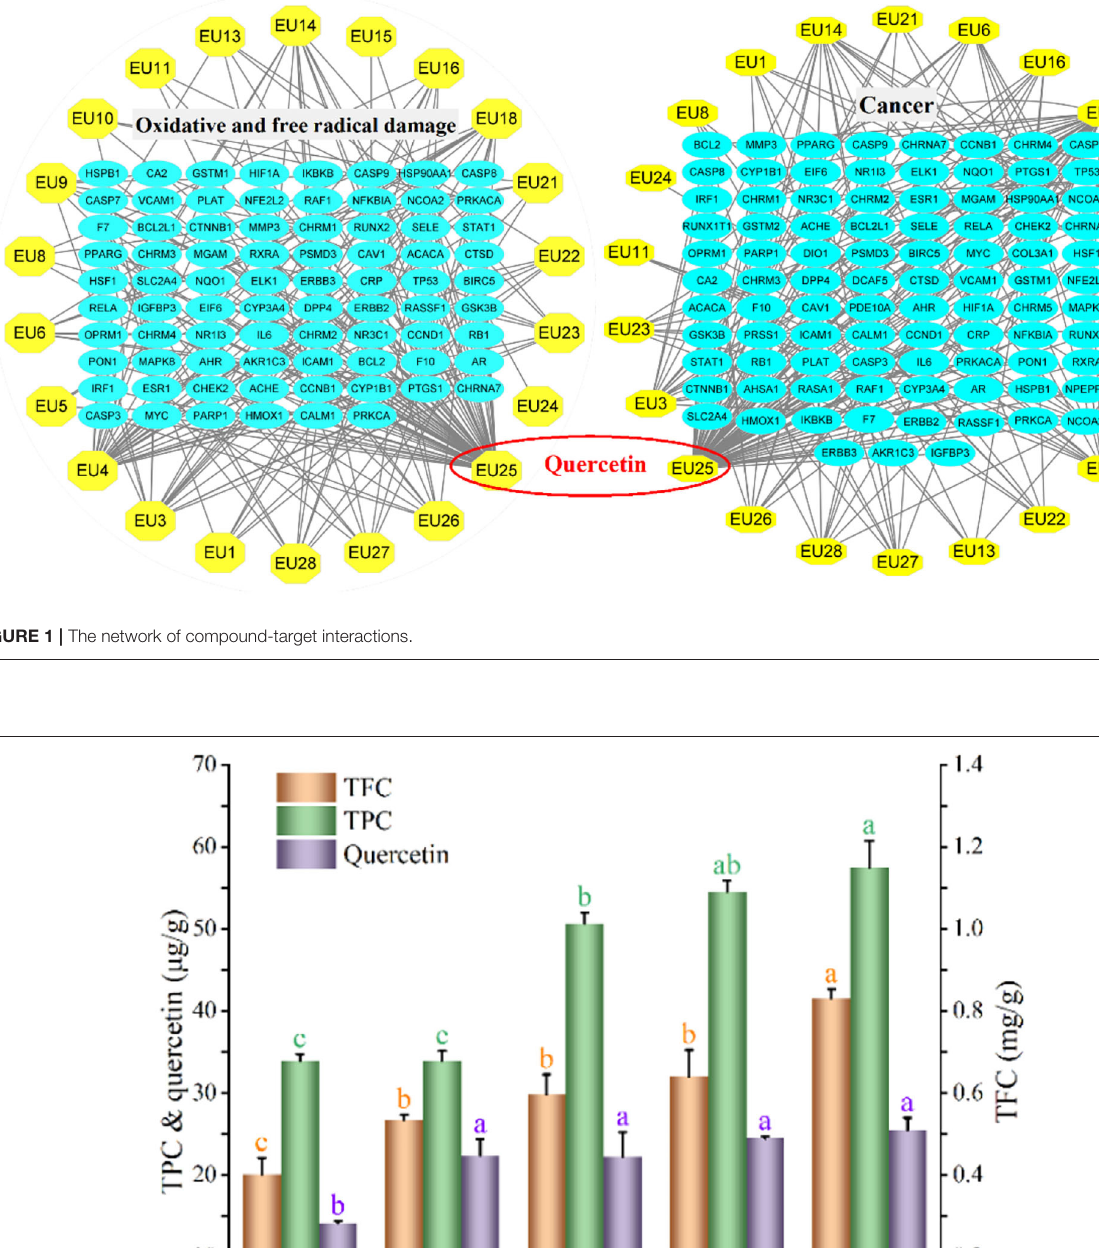
Frontiers in Nutrition | www.frontiersin.org